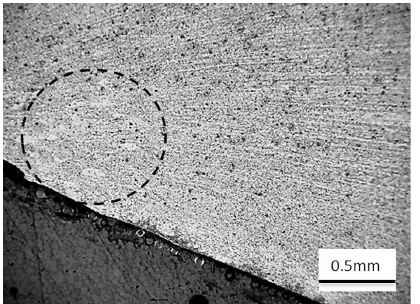
Fig. 11. Microstructure of the specimen produced according Regime C technology (the dashed circle shows small brighter areas – the origins of recrystallization)